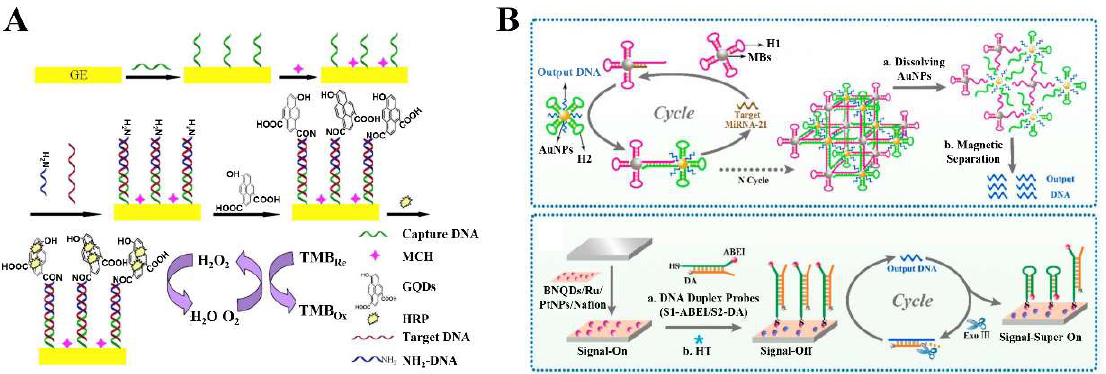
Figure 2. The 2D-QD-based electrochemical DNA biosensors. ( A ) Detection of microRNA-155 using GQD-based electrochemical biosensor. Adapted with permission from Ref. [72]. Copyright 2016 Elsevier. ( B ) Construction of ECL biosensor based on BNQDs/Ru/PtNPs/Nafion nanocomposites combined with 3D DNA network for signal amplification. Adapted with permission from Ref. [74]. Copyright 2019 American Chemical Society.